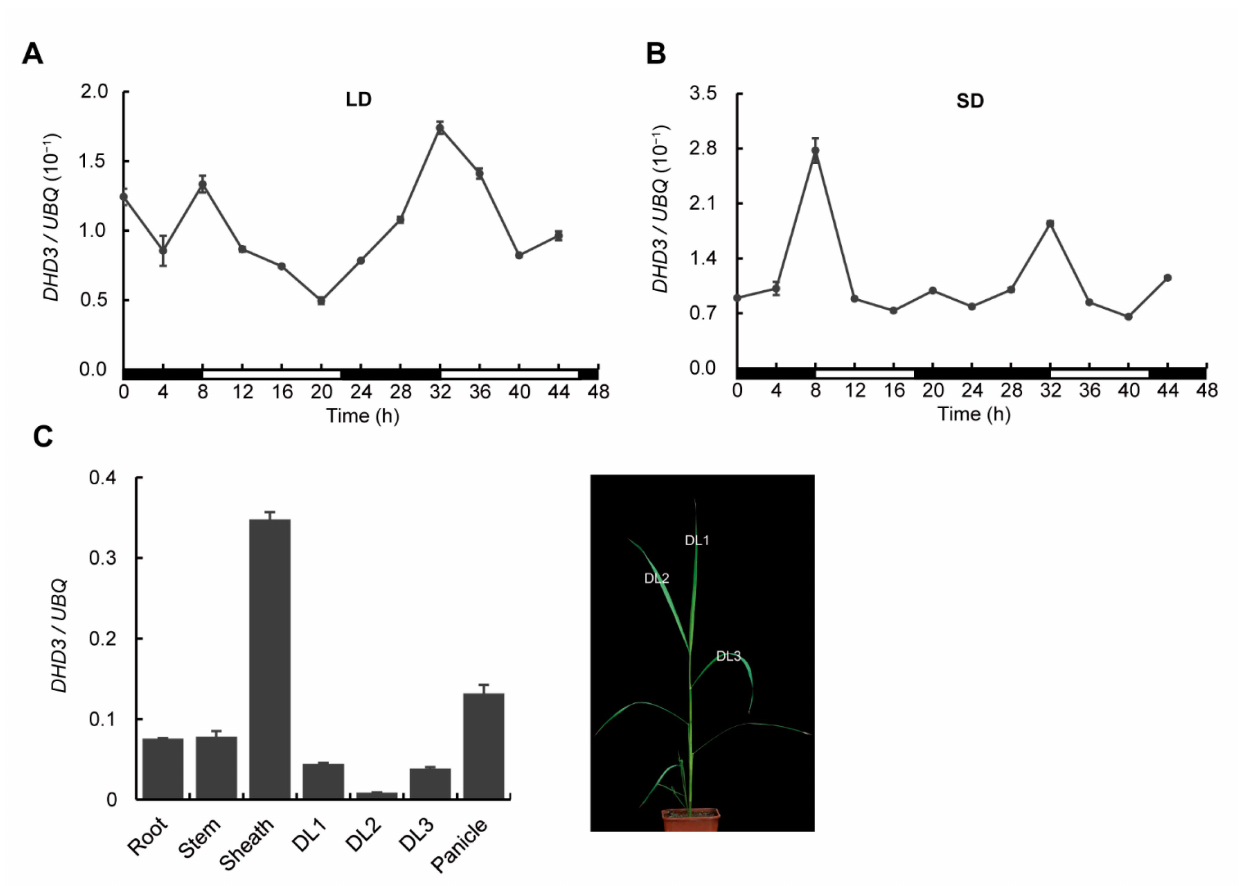
Figure 3. Expression patterns of DHD3 by RT-qPCR analysis. ( A , B ) Diurnal expression pattern of DHD3 under LD and SD conditions. Black and white boxes denote dark and light periods, respectively. ( C ) Relative expression of DHD3 in different rice tissues, including root, stem, sheath, developed leaf (DL), and panicle. Data are means ± s.e. of three biological replications. Scale bars, 2